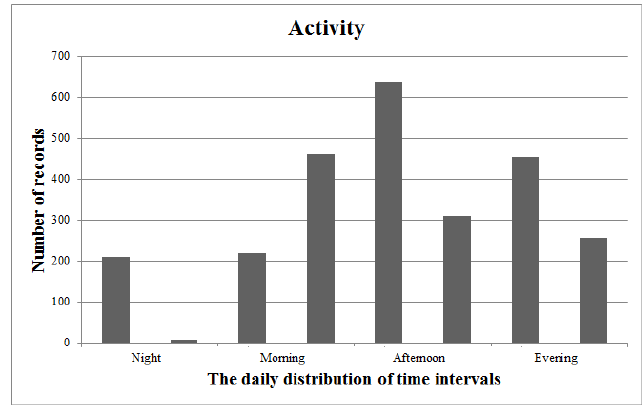
Fig. 5. Activity level across day.